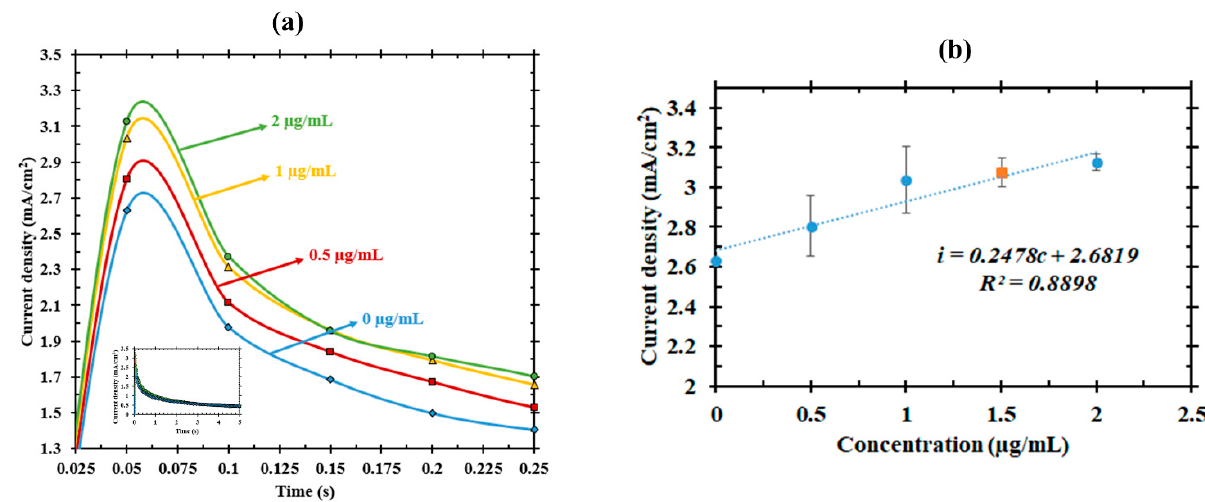
Figure 3. ( a ) Chronoamperometry plot showing the electric current response of different concentrations of SARS-CoV-2 protein as a function of time. The current densities were obtained by applying a fixed potential of 580 mV for 5 s (Inset) of which the first 250 ms are highlighted. ( b ) The calibration plot obtained by plotting the current density value at 50 ms for different protein concentrations tested (blue points). The orange square corresponds to the concentration of sample solution predicted using the calibration equation i